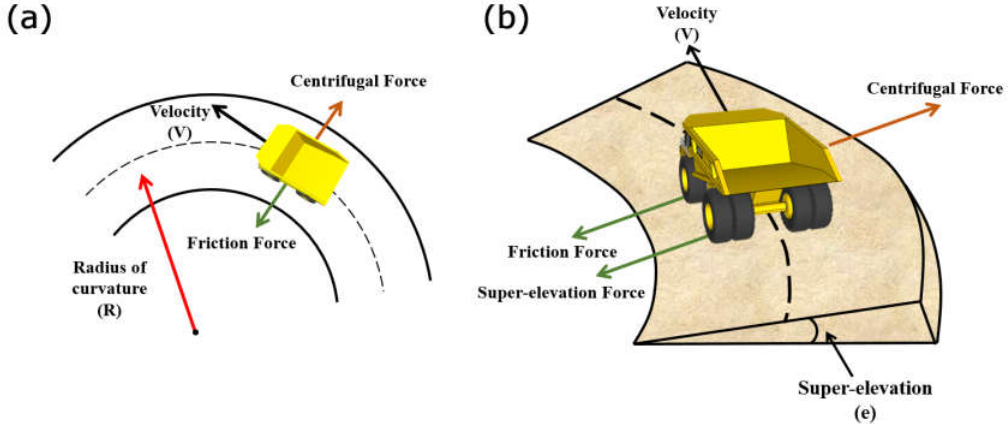
Figure 8. Schematic representation of road geometries showing the ( a ) radius of curvature when the dump truck turns and ( b ) cross-sectional view of the road showing the super-elevation. Table 1. Super‐elevation of the haul road according to the radius of curvature and the vehicle speed [2].